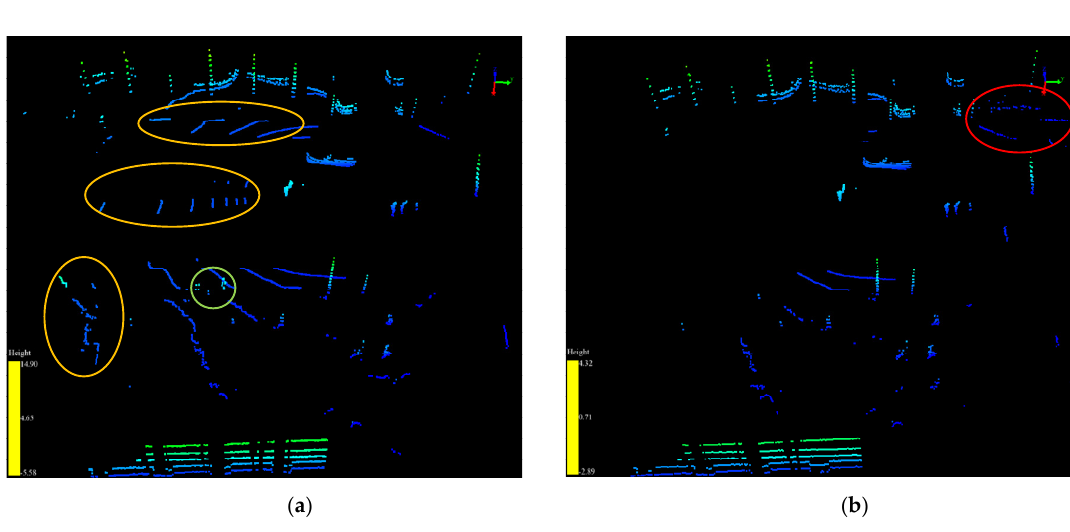
Figure 15. The AGPs and VOPs extraction results with and without fitting of the inclination angle between the BGP and the projection plane. ( a ) The extraction result with fitting of the inclination angle. ( b ) The extraction result without fitting of the inclination angle.